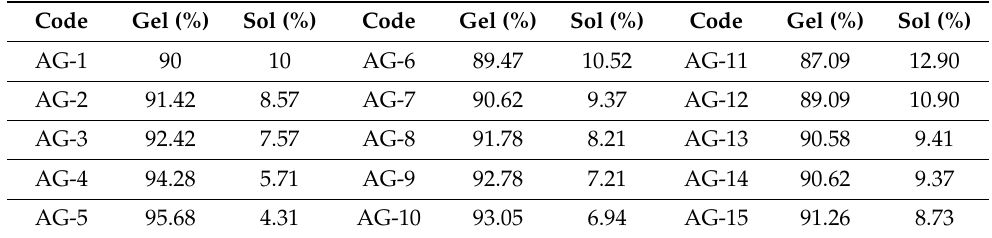
Table 2. Sol and gel (%) of HP- β -CD-g-poly (AA)/gelatin semi-IPN